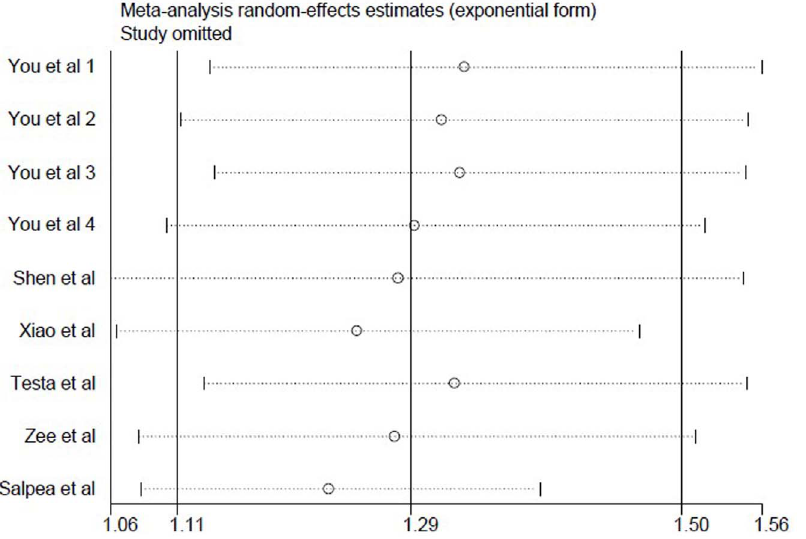
Figure 3. Sensitivity analyses of selected studies. Each line showed the recalculated pooled relative risk of remaining studies by omitting one study listed in the left volume a